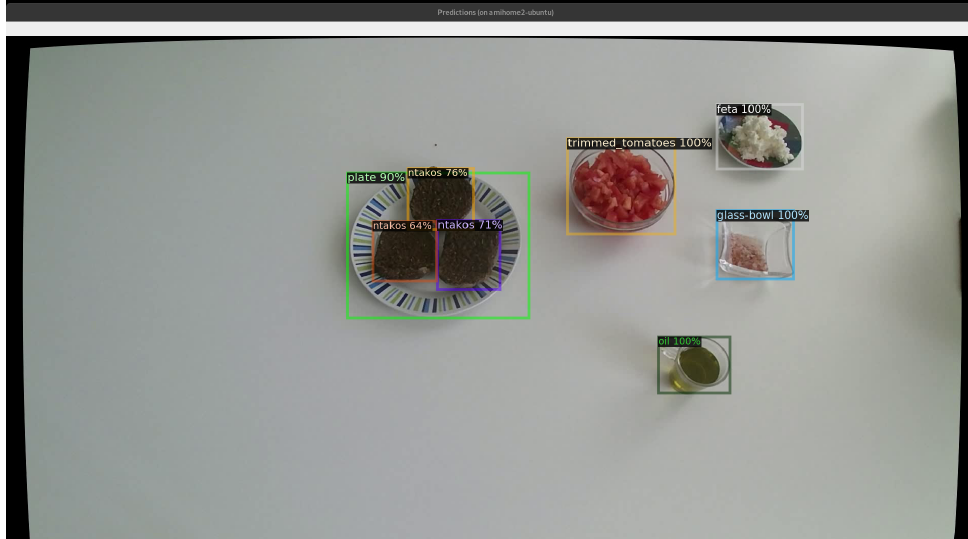
Figure 2. The output of the trained model: bounding boxes, scores and